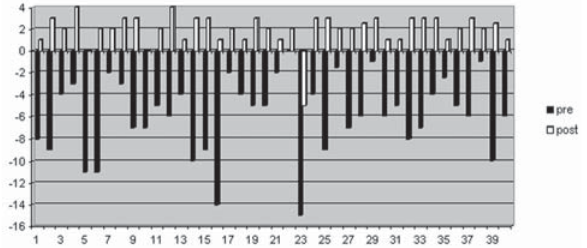
FIGURE 2- Pre-and post-surgical overjet (mm) of the 40 patients who underwent maxilla